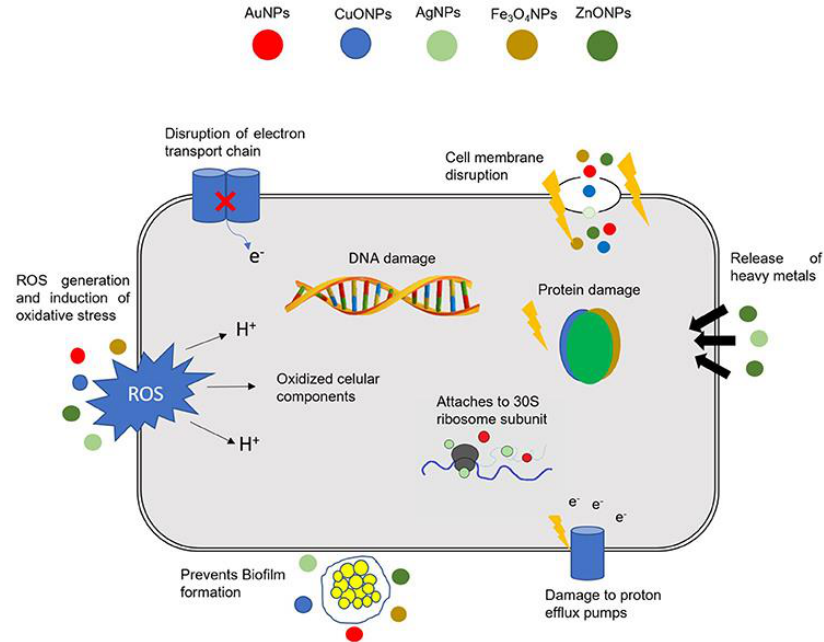
Figure 2. Different mechanisms of action of nanoparticles (NPs) in bacterial cells. The combination of a multitude of cellular effects in a single nanomaterial may have a tremendous impact in fighting multidrug resistant (MDR) bacteria. DNA, deoxyribonucleic acid; ROS, reactive oxygen species; AuNPs, gold NPs; CuONPs, Copper oxide NPs; AgNPs, silver NPs; Fe3O 4 NPs, iron oxide NPs; ZnONPs, zinc oxide NPs. Reproduced from [28], with permission from Front. Microbiol., 2018.